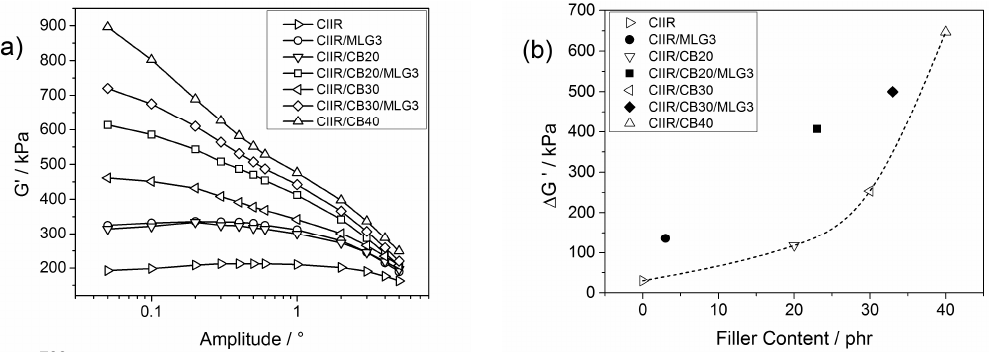
Figure 5. ( a ) Storage modulus as a function of the strain amplitude of CIIR and its composites; and ( b ) difference between initial and final storage modulus as a function of the filler content; the line is a visual guide.